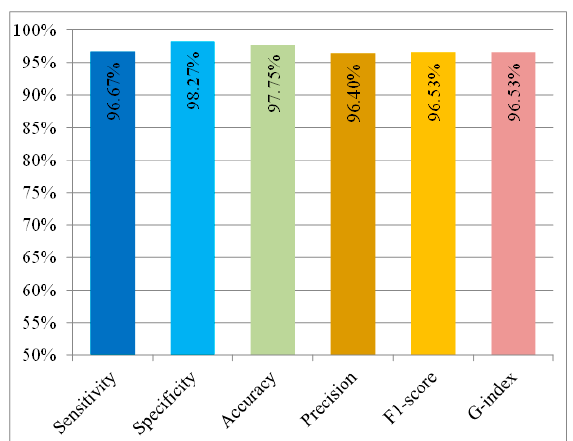
Figure 9. Metrics for evaluation of algorithm performance in falling tests and ADL tests (sensitivity, specificity, accuracy, precision, G index, and F1-score).